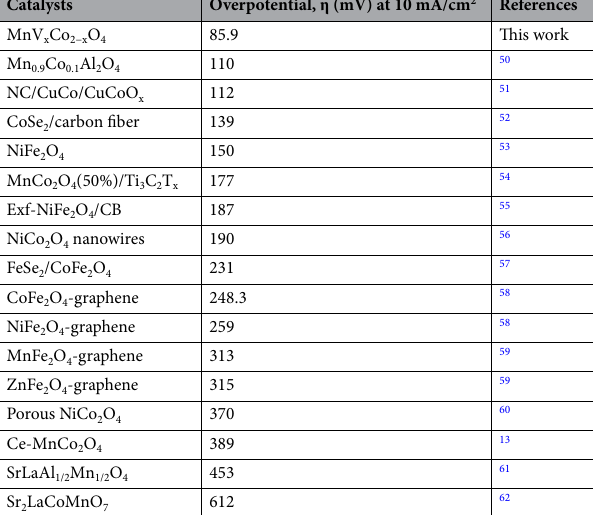
Catalysts Overpotential, η (mV) at 10 mA/cm 2